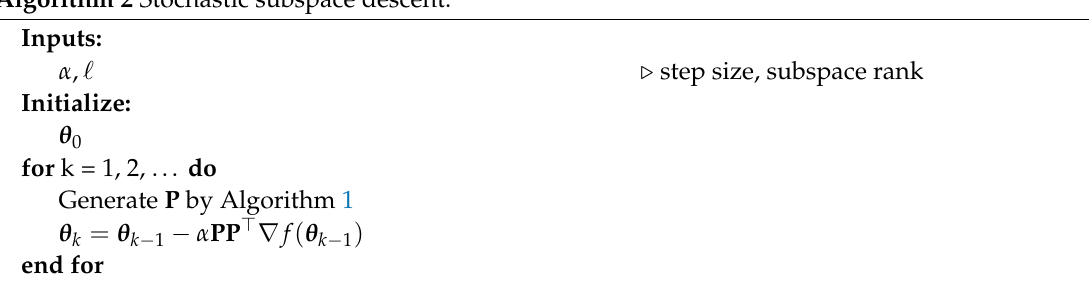
Algorithm 2 Stochastic subspace